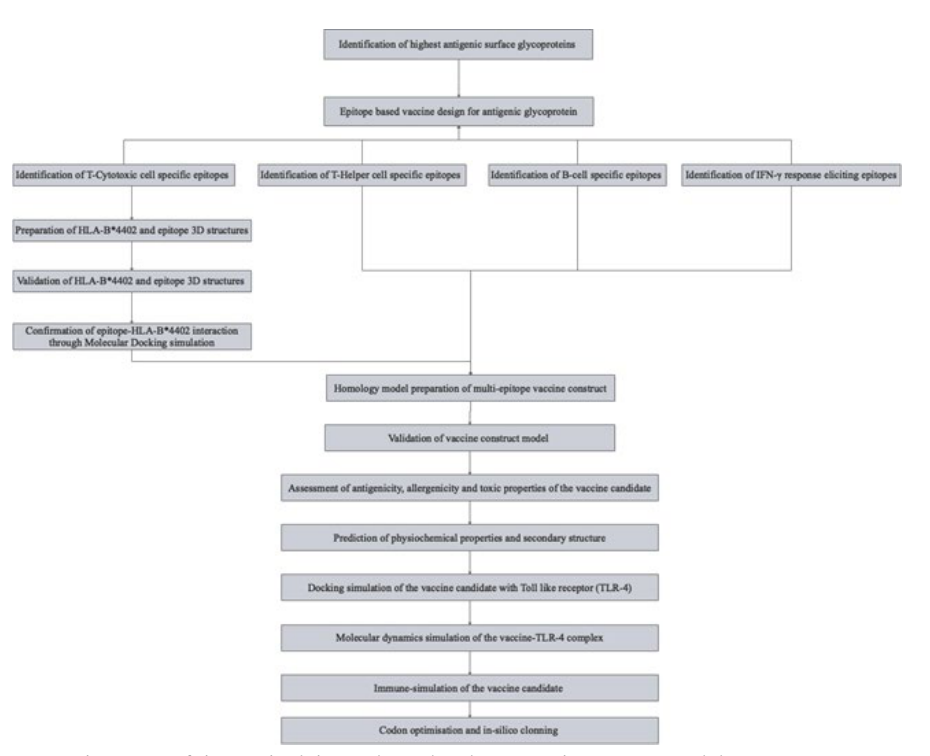
Fig. 1. Schematics of the methodology adopted in designing the vaccine Table 2. T-Cytotoxic cell specific epitope-HLA-B*4402 docking simulation results